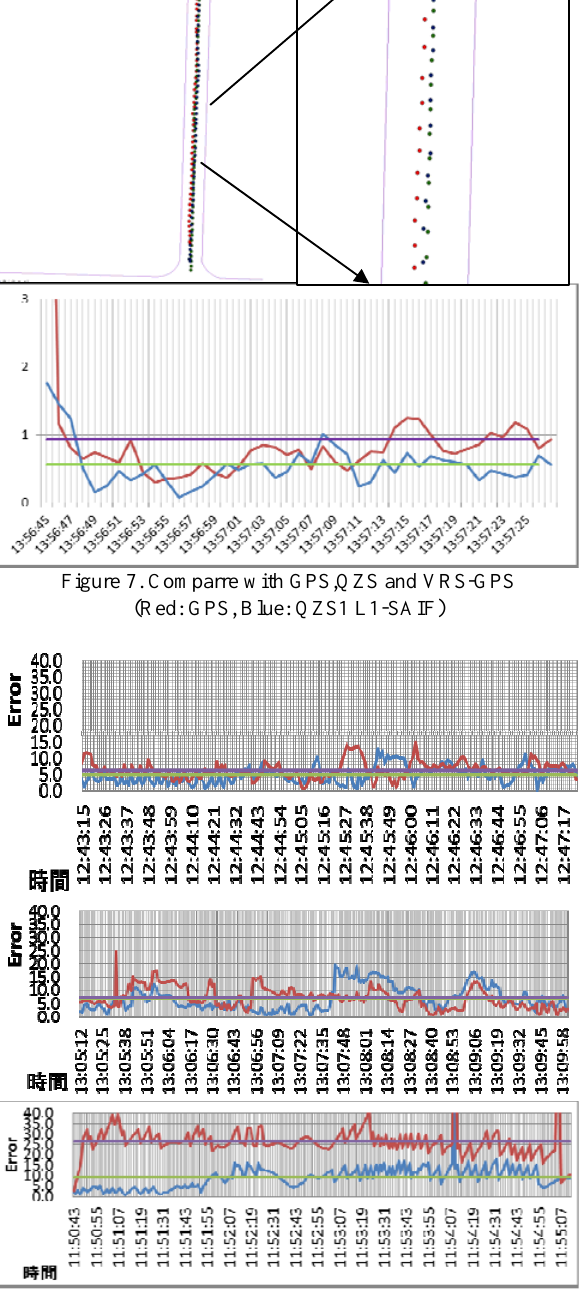
Figure 8. Positioning accuracy on a car (Red: GPS, Blue: QZS1 L1-SAIF) Table 3. Accuracy (unit: